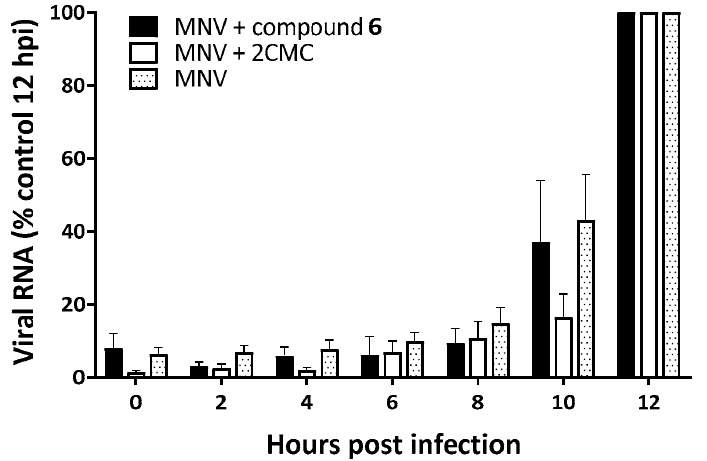
Figure 3. Time-of-drug-addition (TOA) studies of MNV-infected RAW264.7 cells, either un- Figure 3. Time ‐ of ‐ drug ‐ addition (TOA) studies of MNV ‐ infected RAW264.7 cells, either un ‐ treated or treated with compound 6 or the nucleoside analog 2CMC. TOA studies of RAW264.7 cells infected and untreated (dotted bar) and RAW264.7 cells infected and treated with compound 6 (black bars) or 2CMC (empty outlined bars). Results are mean values ( ± SEM) of 3 independent